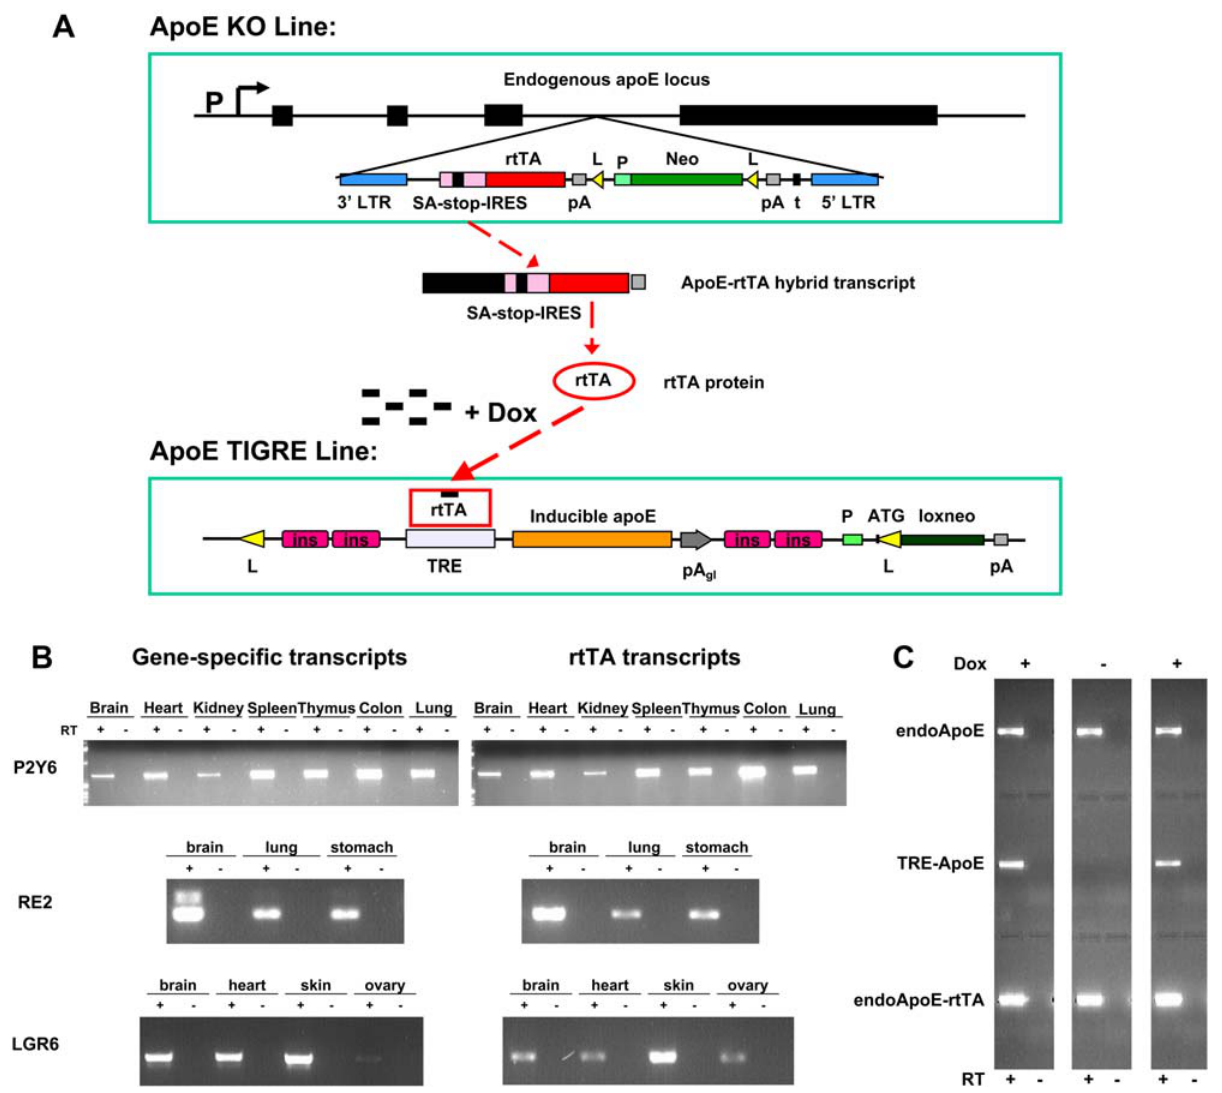
Figure 6. Characterization of gene regulation in iKO mice. (A) Construction and genomic structure of the ApoE iKO mice. Endogenous ApoE gene comprises of 4 exons. In the ApoE KO line, retroviral vector is inserted into the third intron of the ApoE gene, 205 bp upstream of the fourth exon (the largest coding exon). The retroviral vector contains the virus backbone (including 5 9 LTR and 3 9 LTR), a splice acceptor (SA) – stop codon (stop) – IRES cassette immediately followed by rtTA, a PGK promoter (P) driven neo selection marker flanked by two loxP sites (L), and a transcriptional terminator sequence (t). pA, polyadenylation sequence. From this locus, transcription initiated from the endogenous ApoE gene continues through rtTA to form an ApoE-SA-Stops-IRES-rtTA-polyA hybrid transcript in place of the full-length endogenous ApoE transcript. The rtTA protein is produced from this hybrid transcript through IRES-mediated translation, and in turn turns on the expression of the TRE-ApoE from the TIGRE locus only when Dox is present. The ApoE TIGRE locus contains an exogenous copy of ApoE cDNA driven by TRE and flanked by four copies of chicken b -globin insulator (ins) sequences, two on each side, and a PGK promoter (P) driven loxneo selection marker. (B) Side-by-side comparison of the expression of rtTA and each individual endogenous gene in various tissues by semi-quantitative RT-PCR. Three GPCR genes are shown here: P2Y6, RE2 and LGR6. Heterozygous mice are used so that the endogenous transcripts from the WT allele and the rtTA-containing hybrid transcripts from the KO allele can be amplified from the same RNA preps. Each RT-PCR reaction (RT + ) has an RT- control run simultaneously to exclude any possibility of genomic DNA contamination. (C) Comparison of three transcripts by RT-PCR from the same RNA prep of the liver, the major site of normal ApoE production, of the ApoE + / 2 ;TRE-ApoE mice – endogenous ApoE transcript (endoApoE), TRE-ApoE transcript from the TIGRE locus (TRE-ApoE) and ApoE-rtTA hybrid transcript (endoApoE-rtTA). Mice were fed either with or without Dox. As expected, expression of endoApoE and rtTA were independent of Dox. However, expression of TRE-ApoE was strictly dependent on Dox – it was undetectable in its absence and significantly expressed in its presence, indicating high degree of ApoE regulation achieved in the mice. doi:10.1371/journal.pgen.1000069.g006 those of the endogenous genes to be inactivated. Real-time qPCR i.e. rtTA is expressed in the tissues where the corresponding for 16 tissues (Table S1) also showed high degree of correlation endogenous gene is expressed and the relative ratio across different tissues for each transcript also appears similar between rtTA and between rtTA and endogenous gene from tissue to tissue. Overall, out of the 26 lines examined, 19 lines showed good correlation endogenous gene. In the remaining 7 lines in which rtTA was not between rtTA and the endogenous gene’s expression (Table S2), expressed well, 5 lines had the retroviral vector inserted upstream